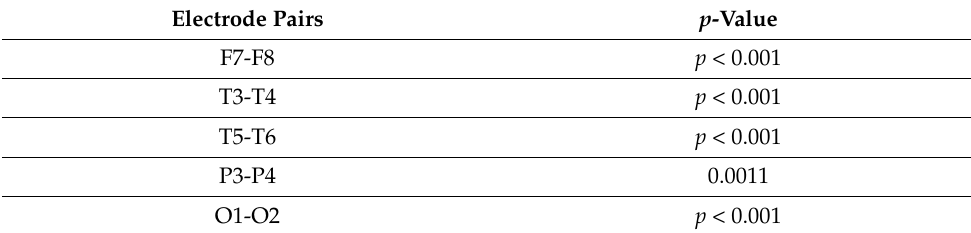
Figure 14. Interhemispheric coherence value of each electrode pair. Table 5. The value of interhemispheric coherence with p < 0.05.